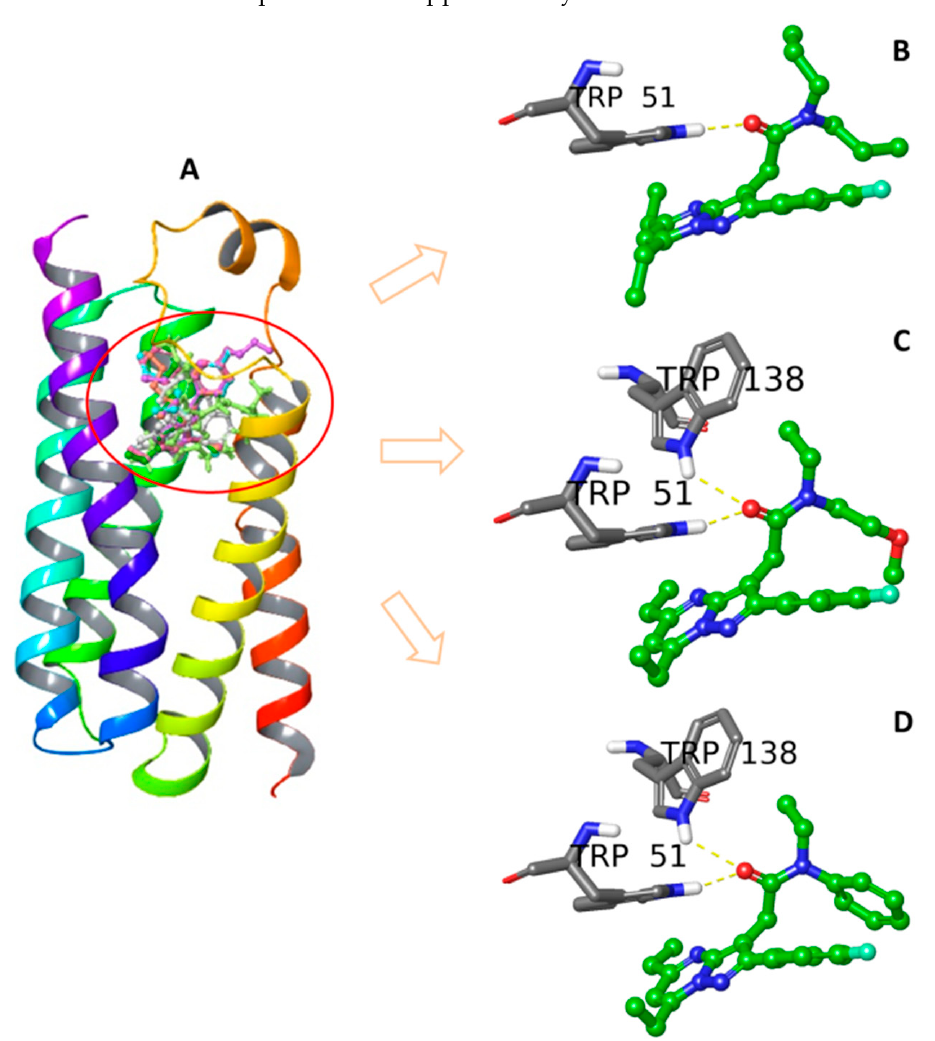
Figure 3. TSPO residues that form the ligand-binding pocket. The most favorable position for ligand binding is shown in green space-filling surface representation ( A ); GMA 10 was docked onto Translocator proteins (BcTSPO) receptor with a docking score of − 9.206, and an H-bond of length 2.6 Å to the binding pocket residue Trp-51 was observed ( B ); GMA 11 was docked onto Translocator proteins (BcTSPO) receptor with a docking score of − 8.988, and two H-bonds of length 2.5 and 2.2 Å to the binding pocket residue Trp-138 and Trp-51 were observed ( C ); GMA 15 was docked onto Translocator proteins (BcTSPO) receptor with a docking score of − 12.443, and two H-bonds of length 2.7 and 2.1 Å to the binding pocket residue Trp-138 and Trp-51 were observed ( D ). The docking results for the control compounds, DPA-714 and PK11195 (TSPO inhib- itors), with the translocator proteins showed low and similar binding a ffi nity scores, indi- cated by − 8.252 and − 10.083, and they showed that an H-bond formed with hydrophobic residue, that is, Tryptophan-51 and Tryptophan-138. In comparison, the docking scores of